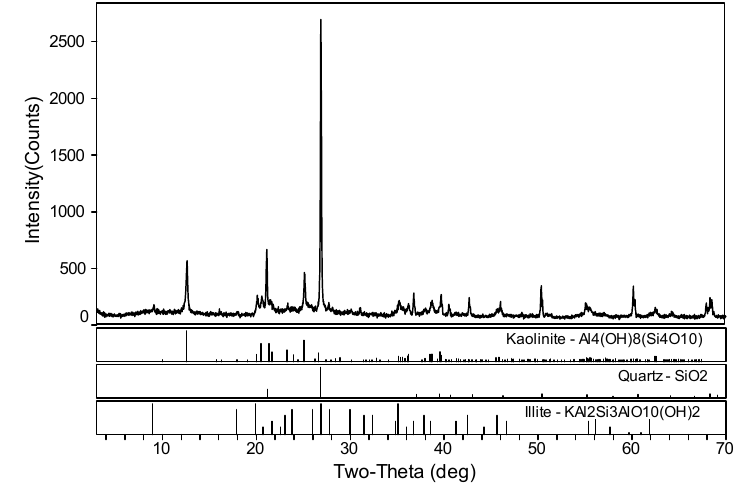
Figure 3. X-ray diffraction pattern of aluminous mudstone.